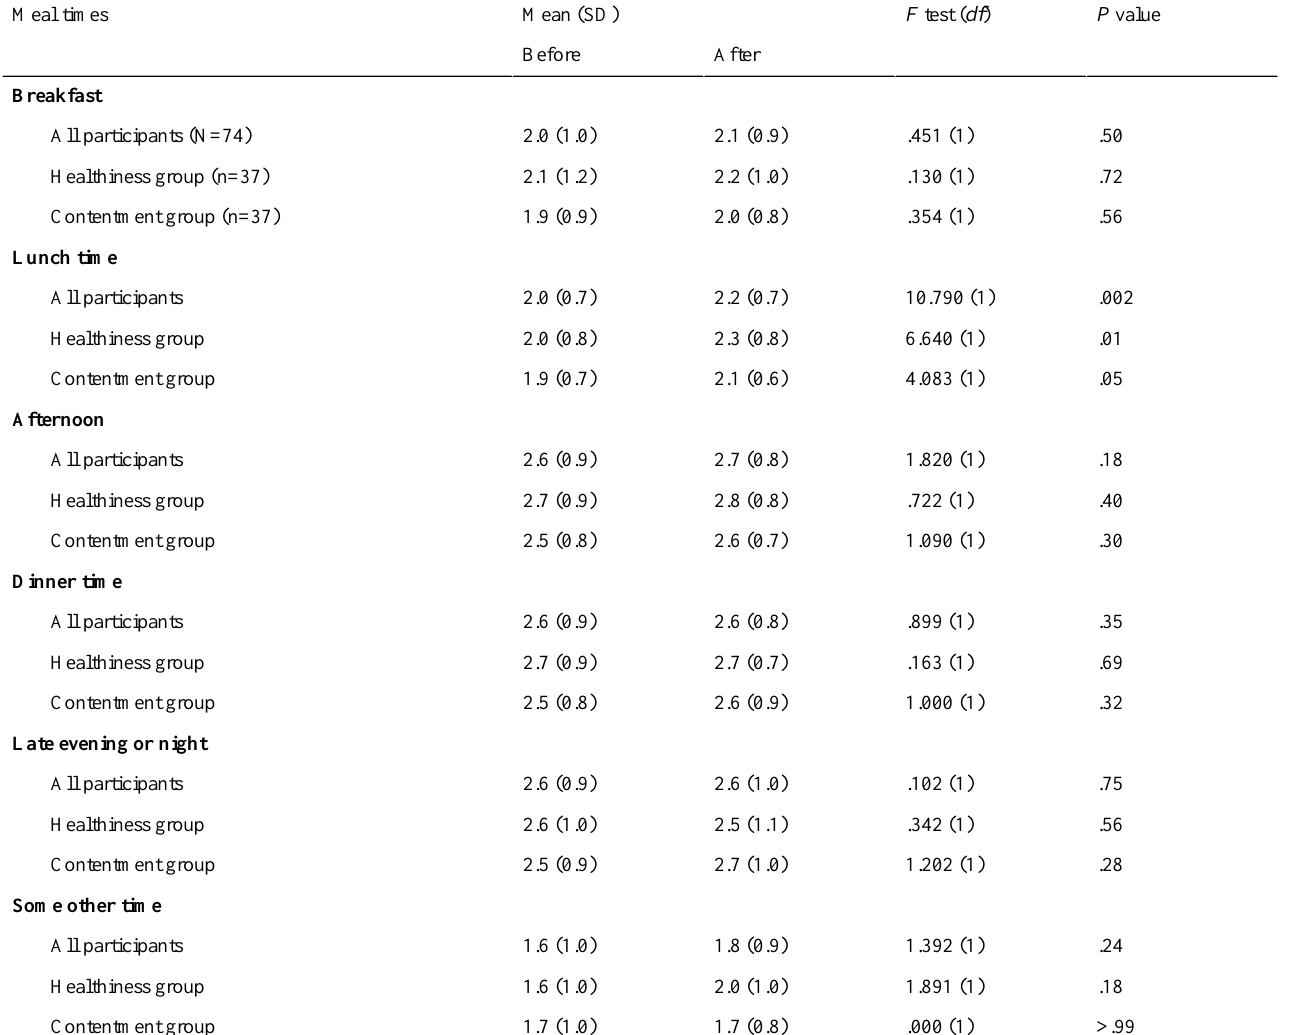
Table 5. Participants’ (all participants and subgroups) evaluations of discontent with their eating habits (scale 1-5, in which 1=never, 5=very often; mean, SD) in different meal times before and after the